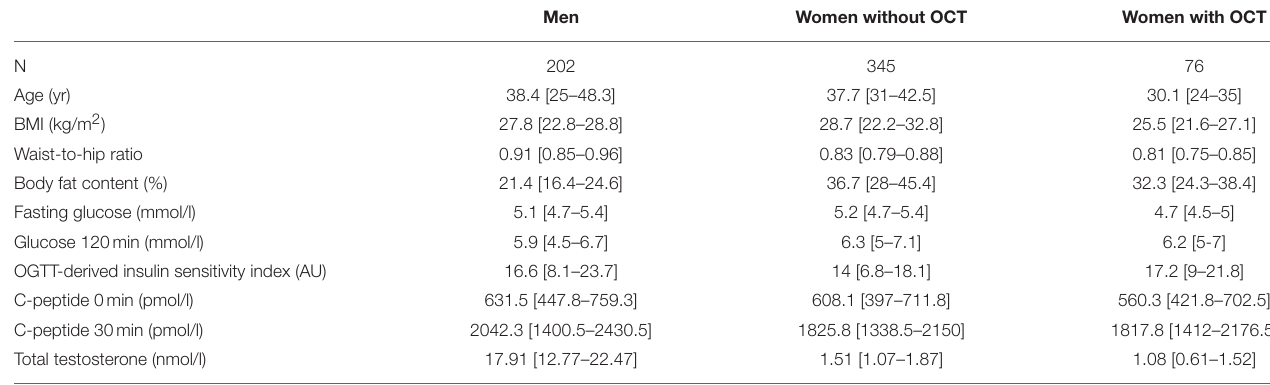
TABLE 1 | Characteristics of the participants.